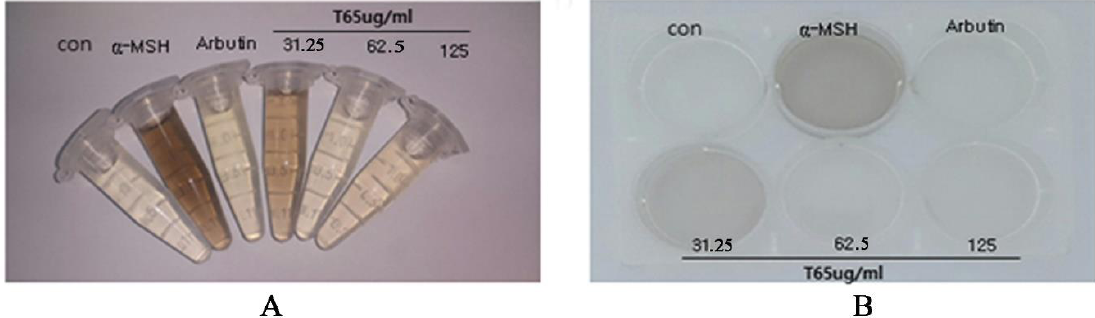
Figure 9. Confirmation of whitening effect in B16F10 cells by T65 crude product. α -MSH: α - melanocyte stimulating hormone used to stimulate melanin. ( A ) Experiment performed in Eppendorf’s tube; ( B ) experiment performed in 6-well plate.